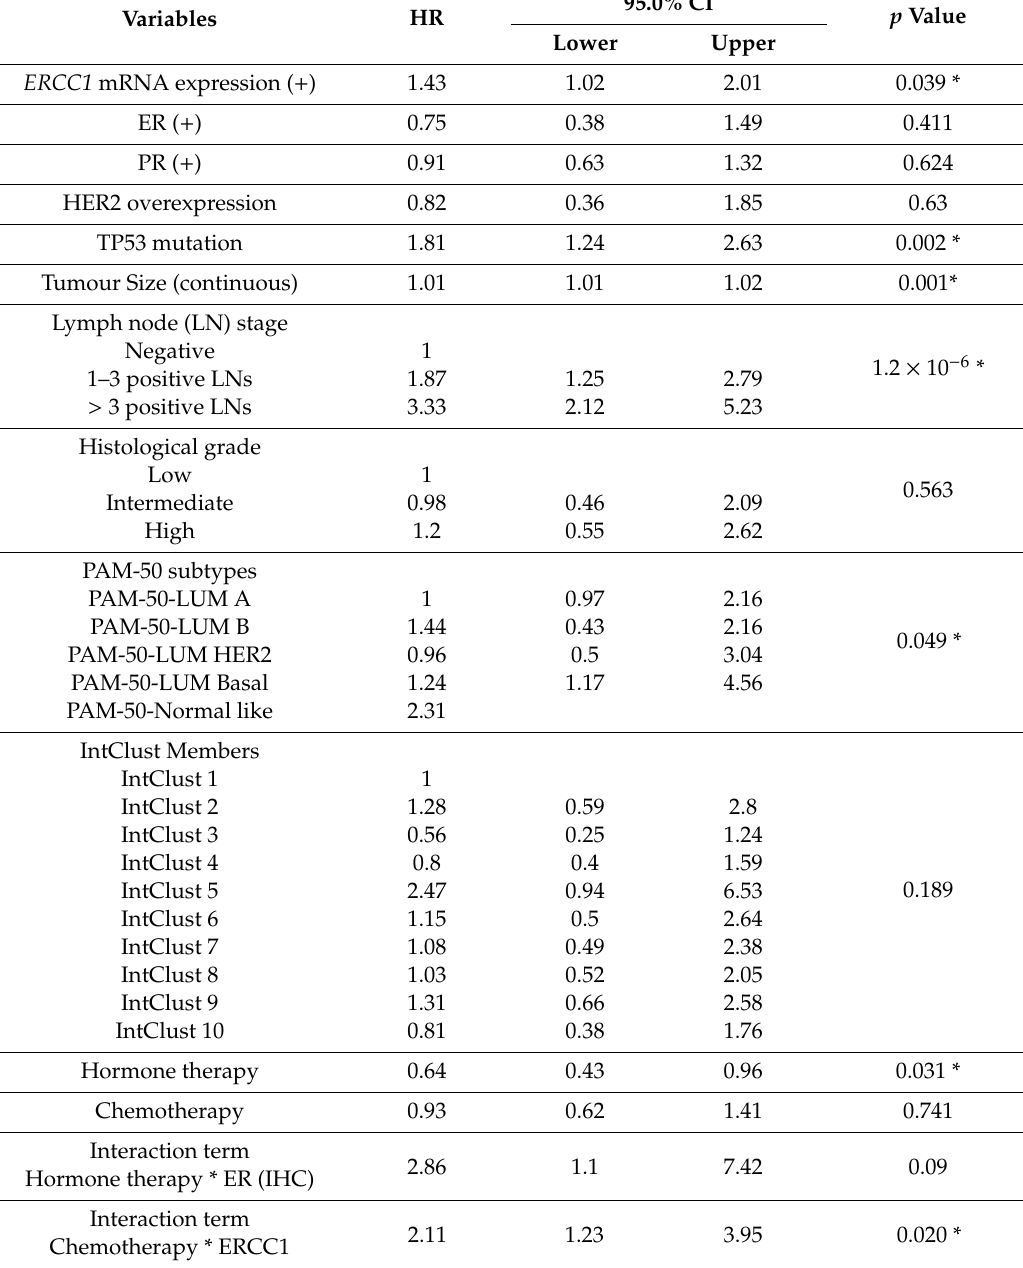
Table 2. Multivariate Cox regression analysis for overall survival (OS) at 20 years in the METABRIC